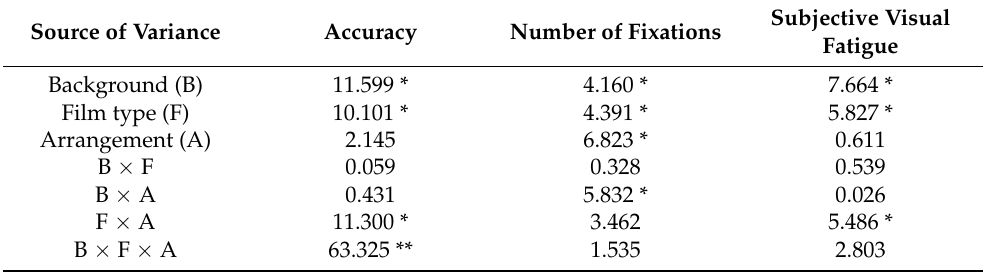
Table 1. ANOVA results for dependent variables.